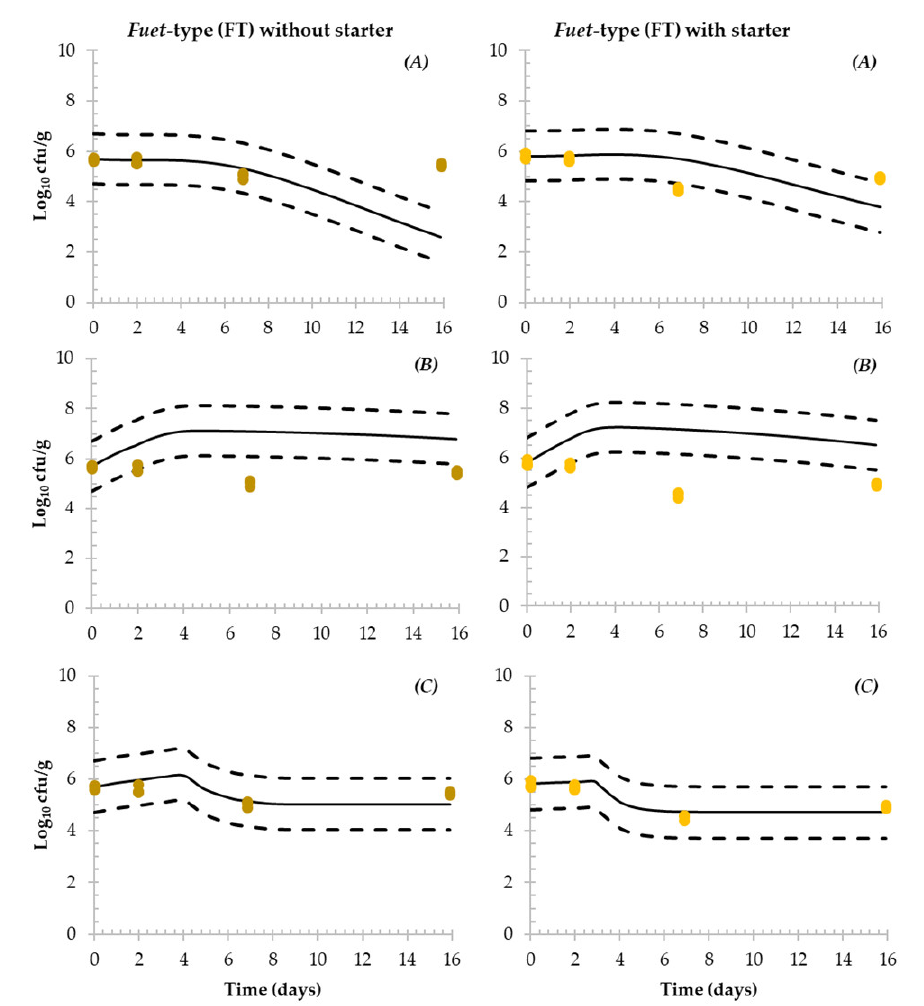
Figure 4. Simulation of Salmonella fate during the production process of fuet -type DFS without ( left ) and with ( right ) starter culture. Simulations were performed in MS-Excel implementing the ( A ) Hwang et al. [30]; ( B ) Pin et al. [31] and ( C ) Coroller et al. [32] predictive models (continuous line). Dashed lines represent the acceptable simulation zone (ASZ) ± 1 Log 10 interval and dots represent the observed Salmonella counts obtained in the challenge